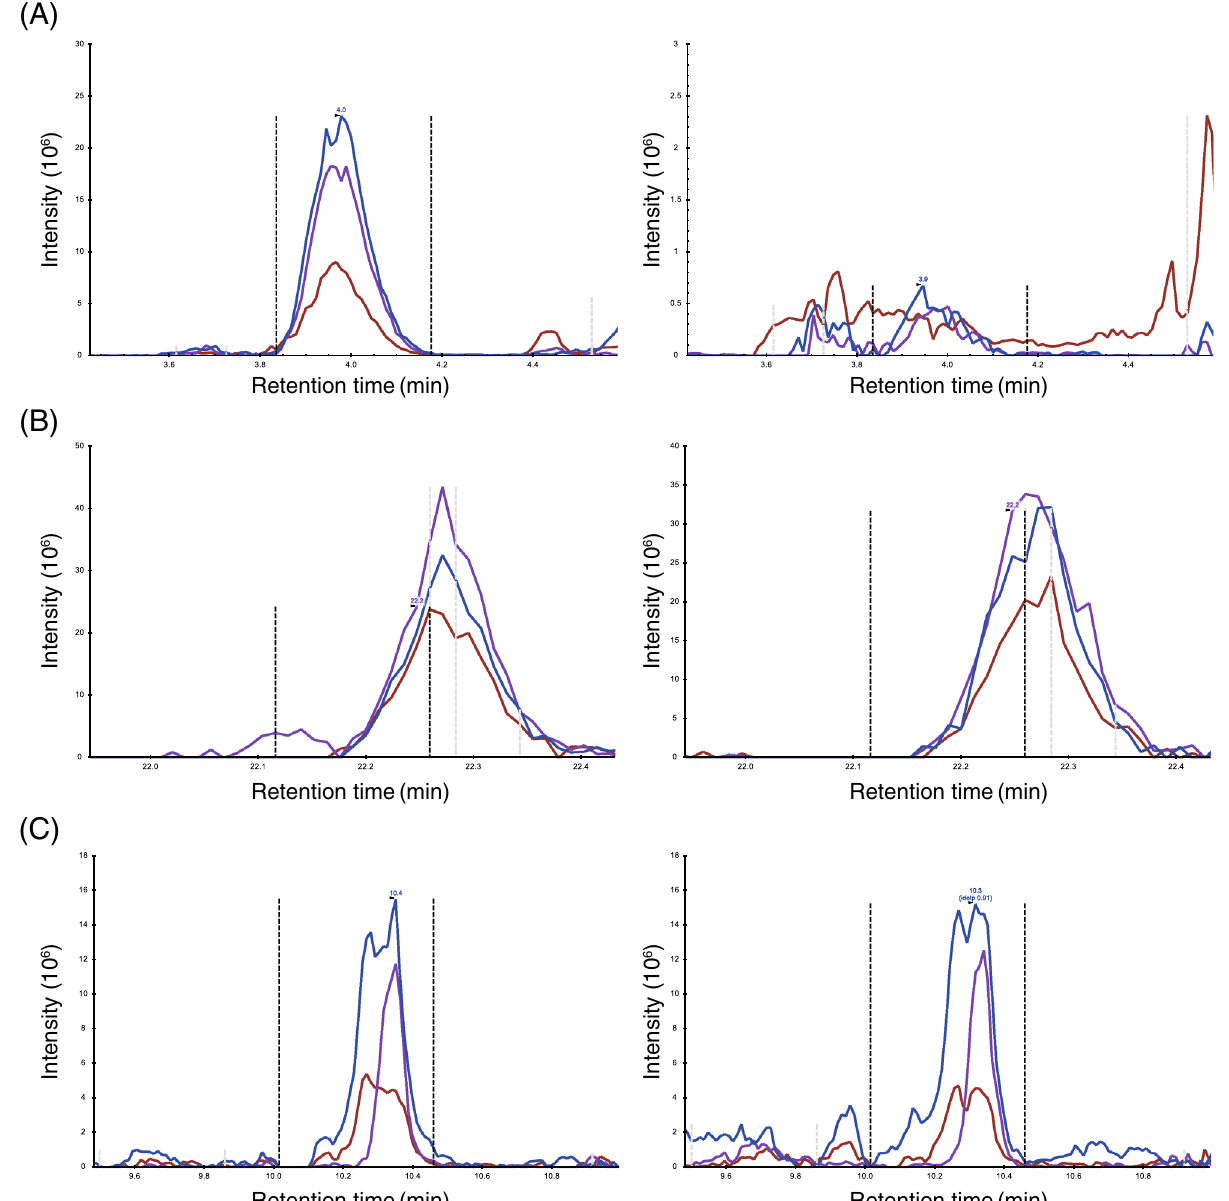
Figure 4. Profiles of chromatographic peaks. The chromatograms of M, M + 1, and M + 2 in heavy- (left) and light-labeled (right) samples are depicted in blue, purple, and brown, respectively. ( A – C ) Examples of outliners in the unanimous selection. ( A ) Case of a peak with a low signal intensity misidentified as a true peak. Sequence, K[+ 25]SAPATGGVK[+ 28]K[28 +]PHR; charge = + 4, ( B ) Case of an incorrect integral of interval. Sequence, DGK[+ 28]YHSIK[+ 28]EVATSVQLTLR; charge = + 3, ( C ) Case of differing shapes among isotopes. Sequence, LK[+ 28]QLAAEQGK[+ 28]DIR; charge = +